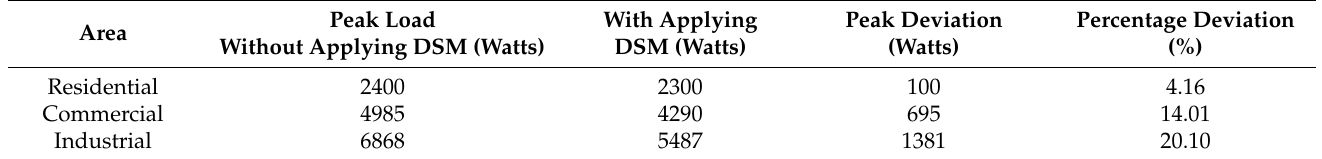
Table 10. Comparison of peak demand reduction during summer.